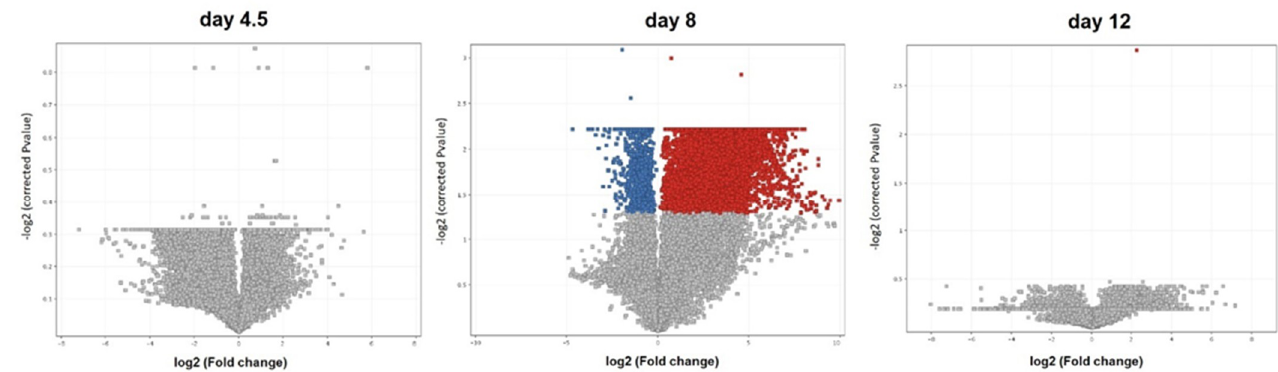
Figure 2. Volcano plot of genes expressed at the three time points of embryonic development of Green-legged Partridge-like (GP) chicken: 4.5, 8, and 12 days (red dots: upregulated genes; blue dots: downregulated genes statistically significant; gray dots: not statistically significant).